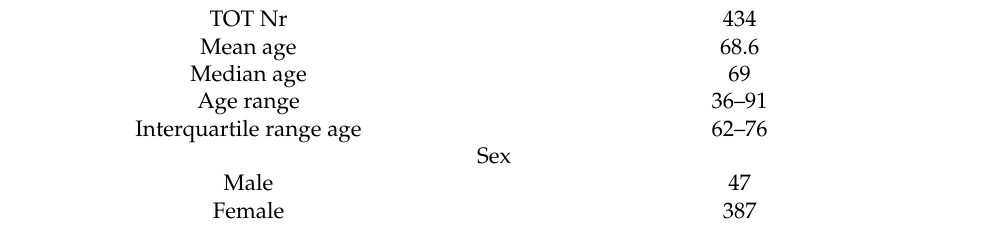
Table 1. The sample consists of 387 females and 47 males, aged between 36 and 91, with an average age of 68.64. The subdivision into quartiles returned a median age of 69, with the first quartile 62, and the third quartile 76.